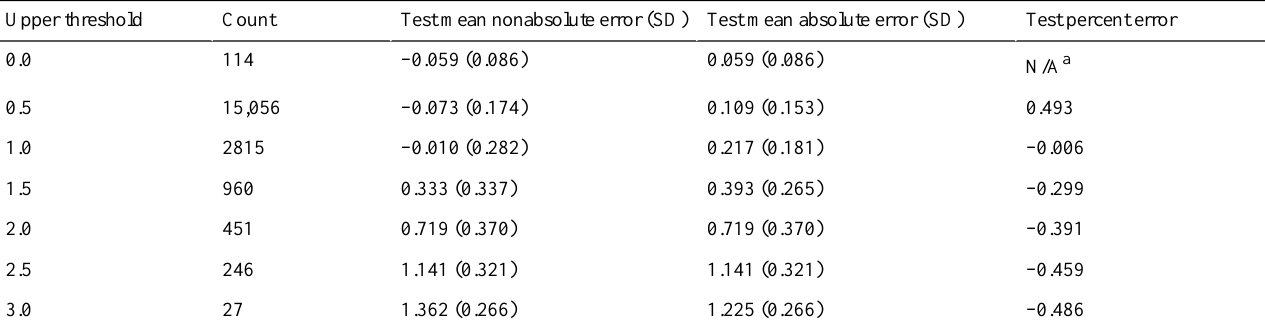
Table 10. Test errors and median percent errors of label bins of size 0.5 for the cross-validation